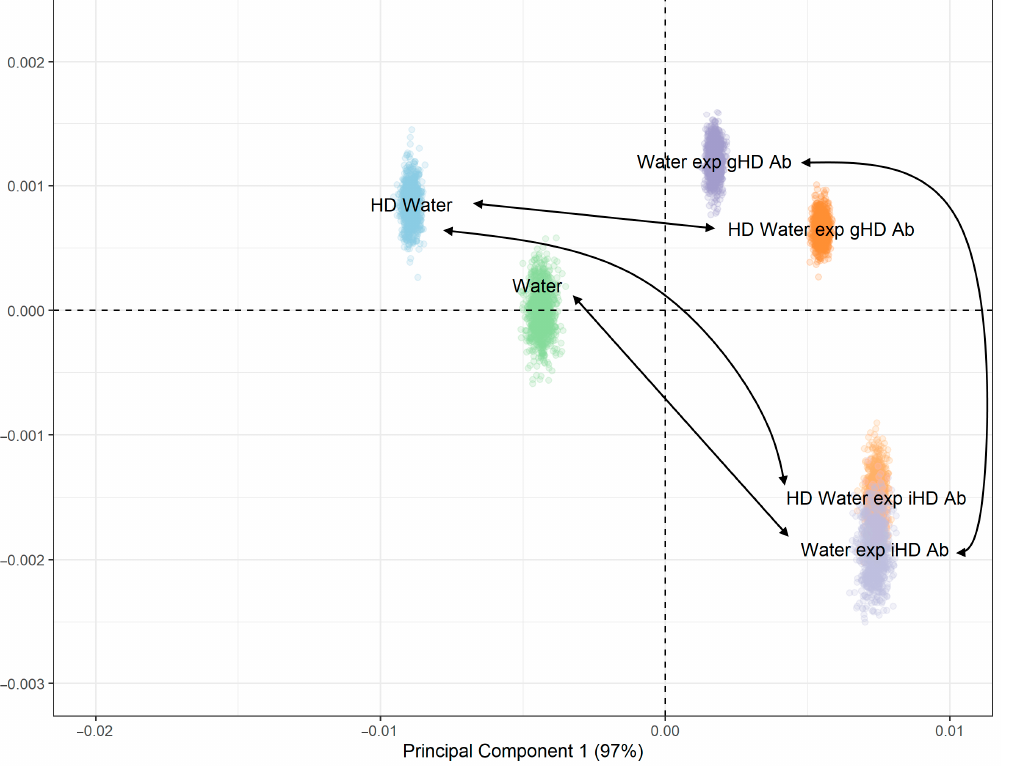
Figure 7. The influence of non-contact impact of iHD Ab and gHD Ab on the distribution of water and HD water samples spectra in the wavelength range of 470–2000 cm − 1 in the space of the principal components. In sample labels, ‘exp’ means ‘exposed to’. Double-sided arrows depict statistically significant differences in the emission spectra between the parenthetical groups ( p < 0.05, comparison of the K-means with the Holm